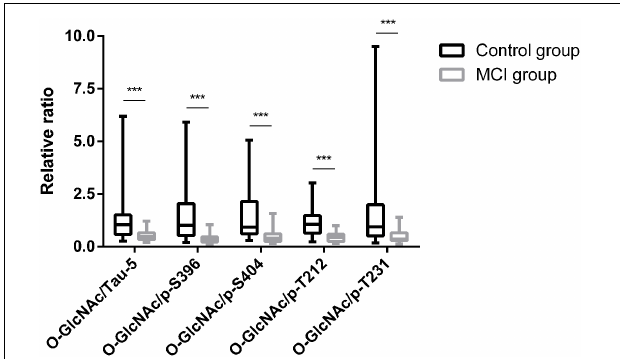
FIGURE 2 | Relative ratio of global O -GlcNAcylation to tau phosphorylation levels in T2DM subjects. O -GlcNAc/Tau-5, O -GlcNAc/p-S396, O -GlcNAc/p-S404, O -GlcNAc/p-T212, and O -GlcNAc/p-T231 were all decreased in T2DM with MCI subjects in comparison to control subjects. All data represents n = 48, and are median (interquartile range). ∗∗∗ p < 0.001.